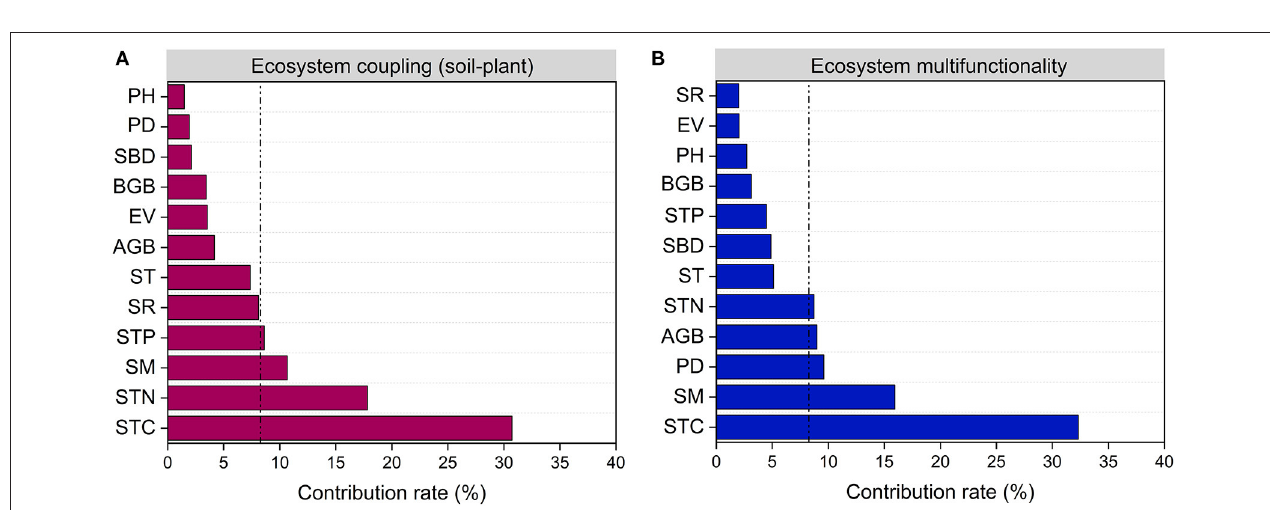
FIGURE 5 | (A,B) Correlations between ecosystem coupling and functionality in each successional stage of alpine meadow. AGB, aboveground biomass; SR, plant species richness; EV, Camargo evenness index; PGI, plant growth index; SCI, soil carbon accumulation index; SNI, soil nutrient index; EMF, ecosystem multifunctionality index; EC_SP, extent of ecosystem coupling (soil-plant).